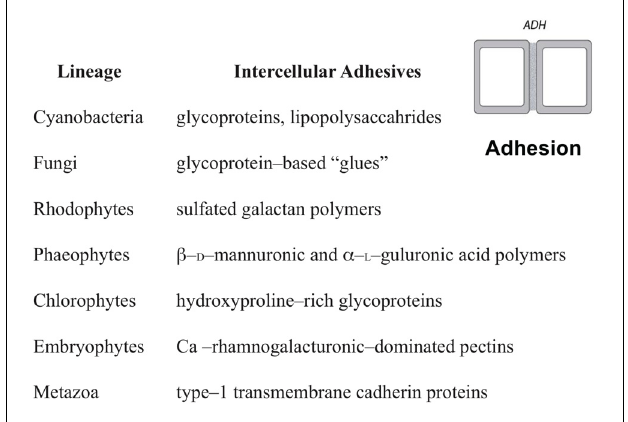
FIGURE 2 | The different adhesives utilized by the cell-to-cell adhesive (ADH) dynamic patterning module among some of the major multicellular